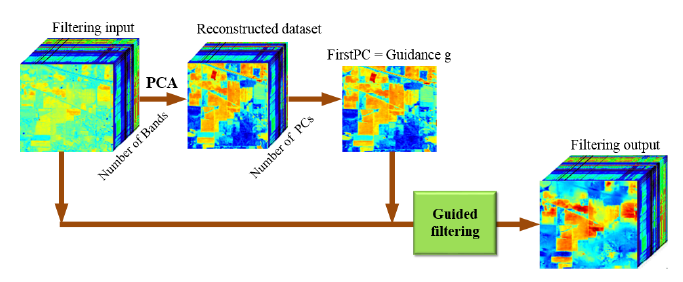
Figure 4. The structure of